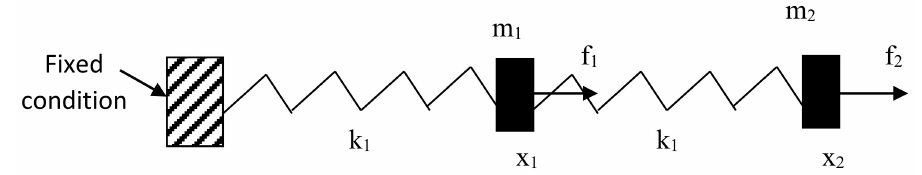
Figure 9. A two degrees of freedom (DOF) system with.